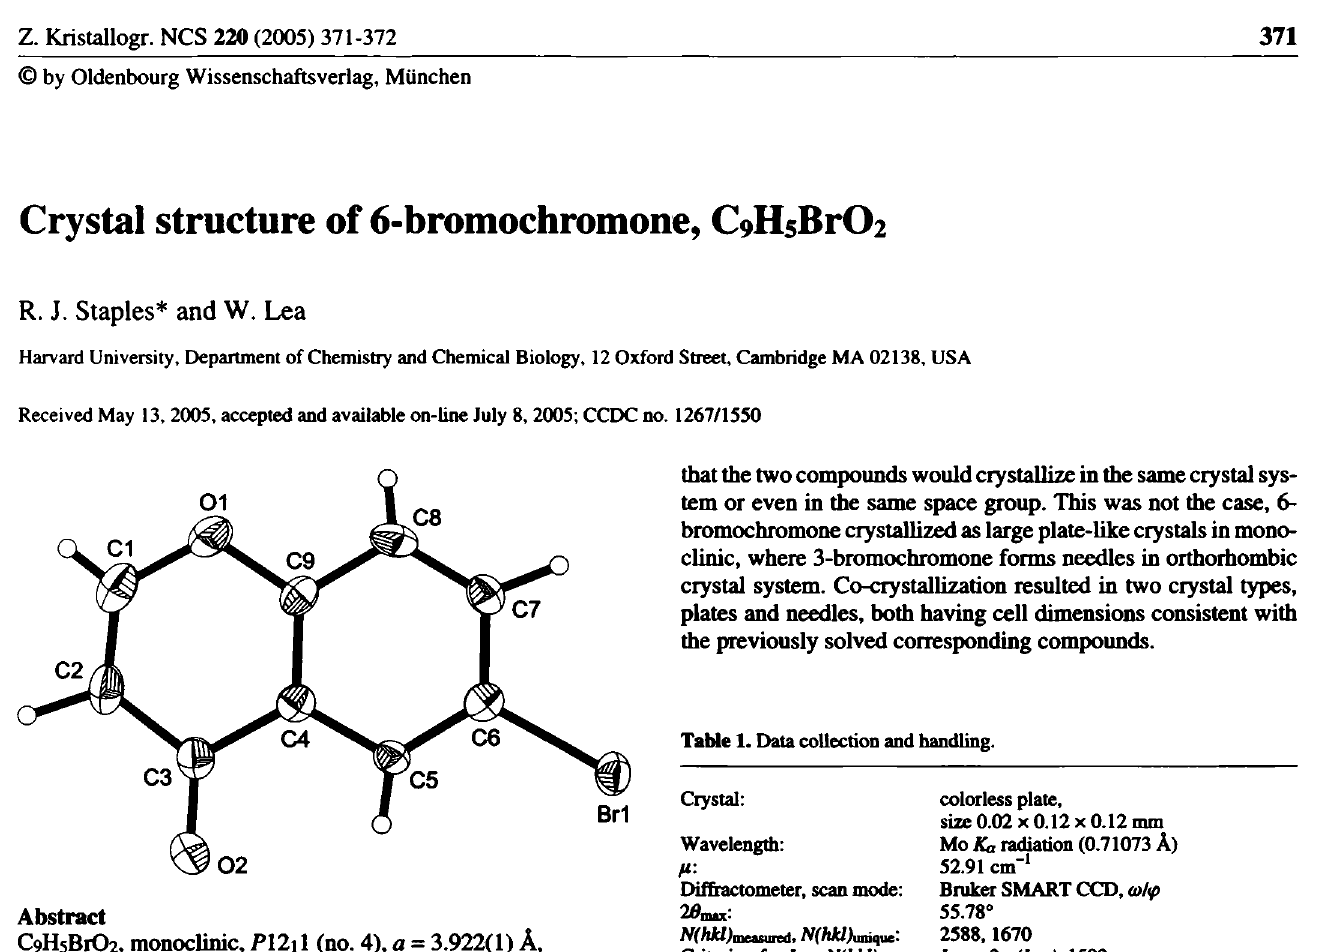
Table 2. Atomic coordinates and displacement parameters (in Ä 2 ).